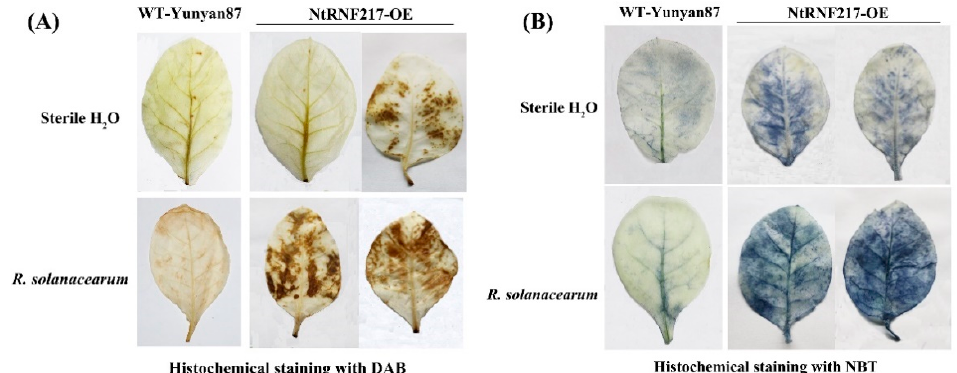
Figure 5. Histochemical staining. DAB ( A ) and NBT ( B ) staining of WT-Yunyan87 and NtRNF217 -OE plants before inoc- ulation and after 24-h Ralstonia solanacearum inoculation. DAB: 3,3-diaminobenzidine, and NBT: nitro blue tetrazolium.